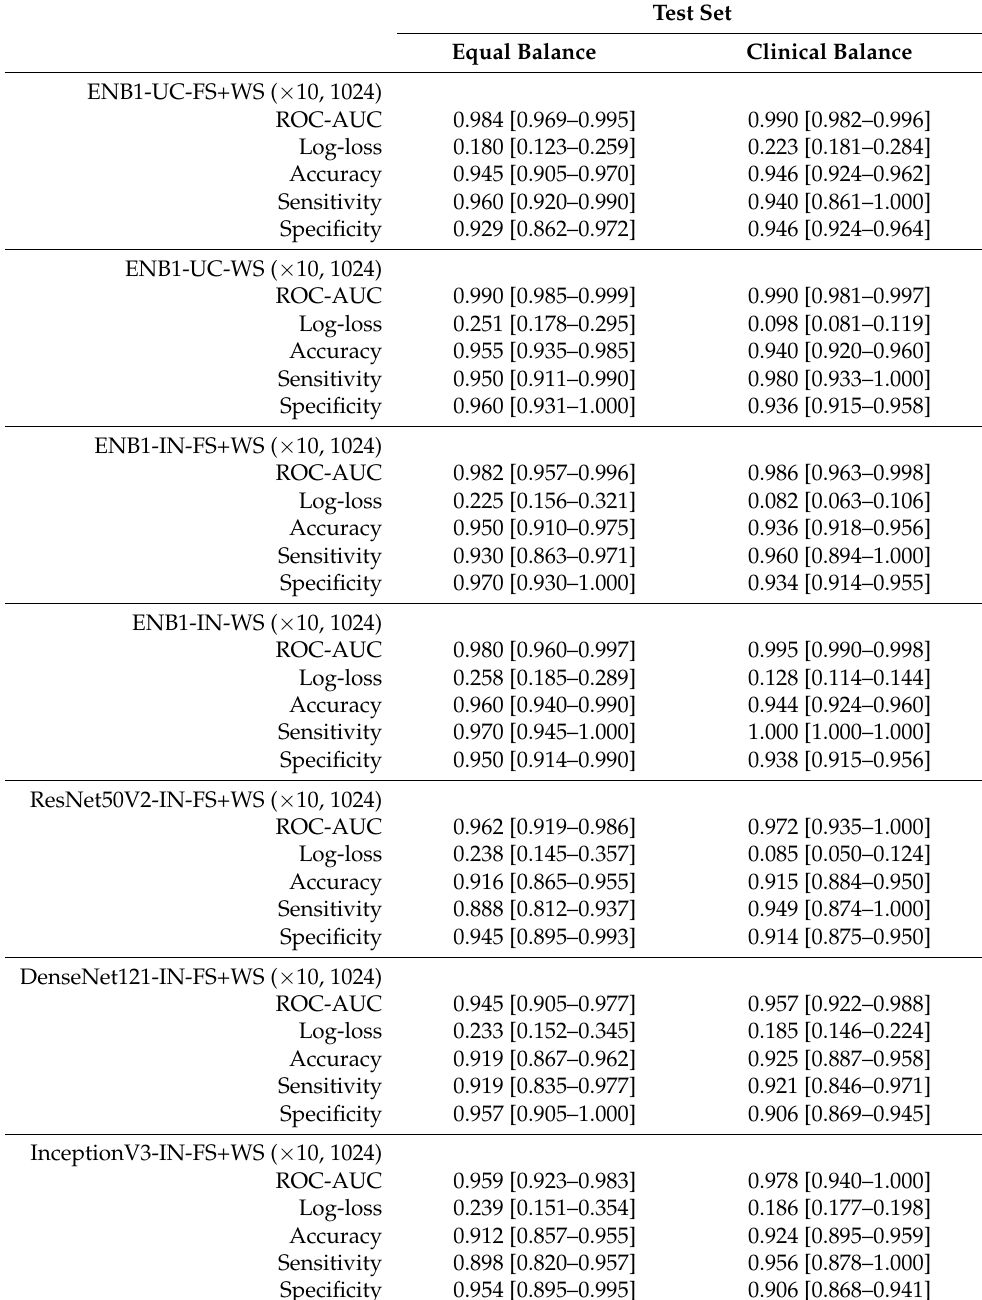
Table 4. ROC AUC, log loss, accuracy, sensitivity, and specificity results on the equal balance and clinical balance test